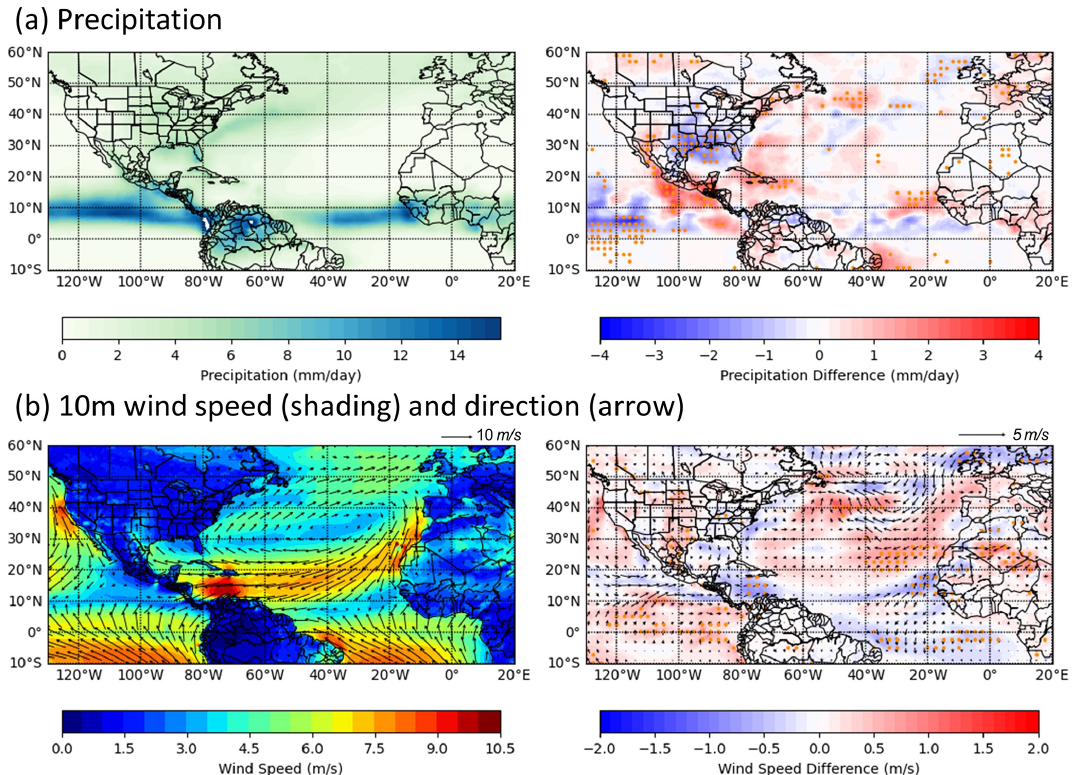
Figure 8. Maps of precipitation (a) and 10m wind speed (shading in b ) and directions (arrows in b ) under the USDM-based SEUS regional non-drought (wet and normal) conditions (left column) and their changes during severe-drought periods (right column) from 2000 to 2019 in JJA. Orange dots (right column) indicate the grids with significant differences in precipitation (a) and wind speed (b) at a 95% confidence